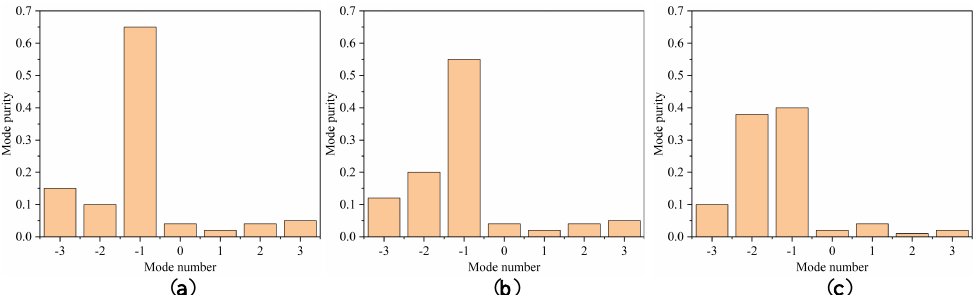
Figure 7. The mode purity analysis for X-polarization once ( a ) r = 4 λ , ( b ) r = 8 λ , and ( c ) r = 12 λ